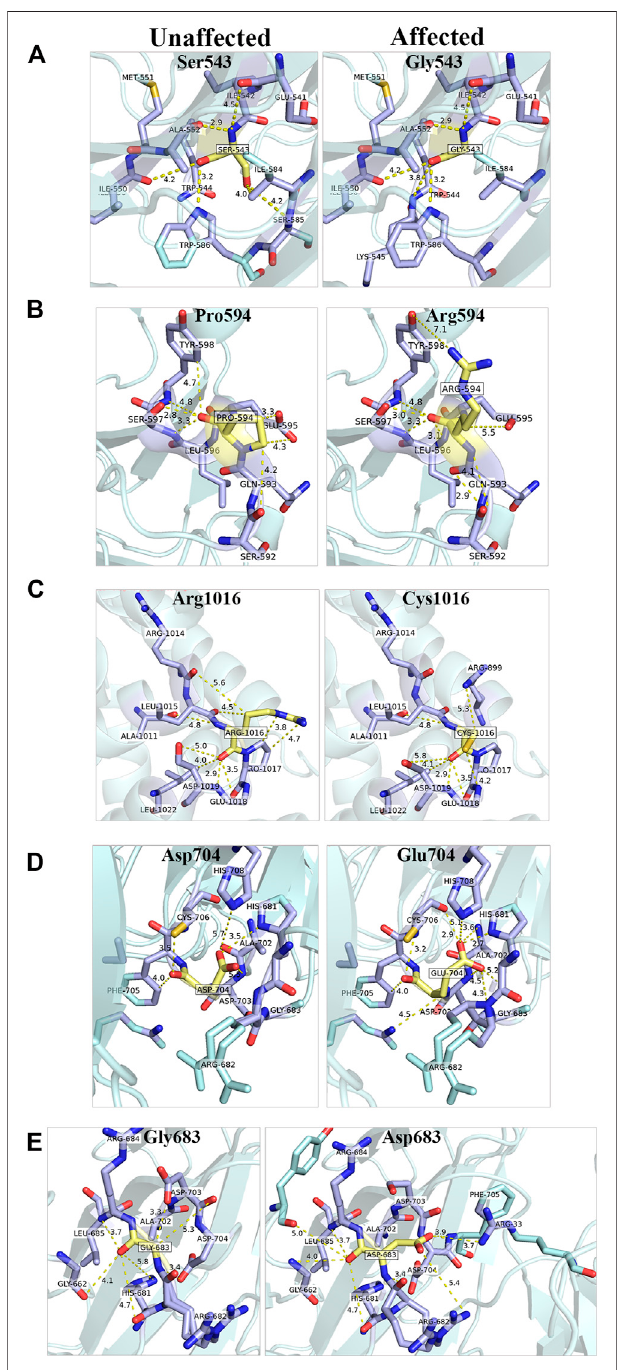
FIGURE 4 | In silico prediction of structural changes caused by the GEMIN5 variants. Structural and interaction-based changes were measured around 5A region of GEMIN5 variants Ser543Gly (A) , Pro594Arg (B) , Asp704Glu (D) , and Gly683Asp (E) intheWD40domain (PDB ID: 5H1J) and Arg1016Cys (C) in the tetratricopeptide (TPR)-like domain (PDB ID: 6RNS) by using Pymol. The affected amino acids are colored yellow and their surrounding amino acid in light